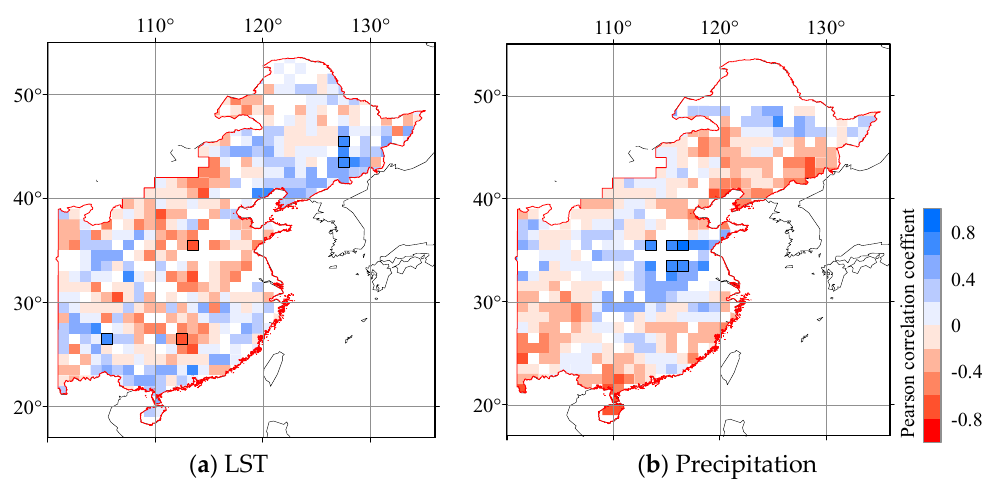
Figure 8. Pearson correlation coefficients between corrected GM-XCO 2 and land surface temperature (( a ), LST) and precipitation (( b ), Precipitation) in the growing period from 2003 to 2016. The corrected method is using CT-XCO 2 fitting. LST and precipitation were from MODIS (MOD11C2 v6) and TRMM (TRMM 3B42), respectively. Color bar shows the correlation coefficients and grid cells with black outline show grid cells with significant correlations ( p < 0.05). Observed changes in temperature and precipitation do not effectively explain the observed trends in GM-XCO 2 .